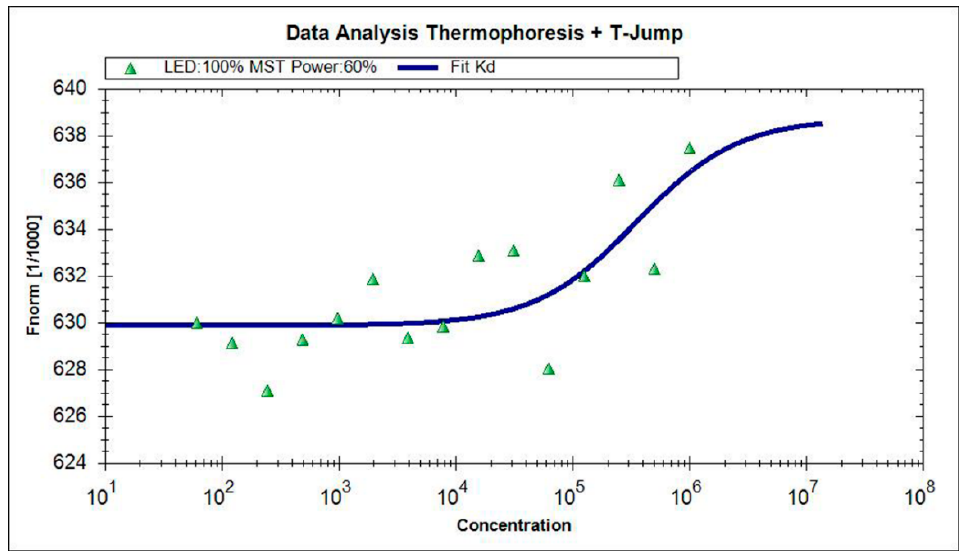
Figure 3. Competitive experiments by MST. The binding of TCH to a constant amount of bLf was quantified. The final bLf was labeled, and TCH was added at varying concentrations (ranging from 122.08 nM to 2 mM).